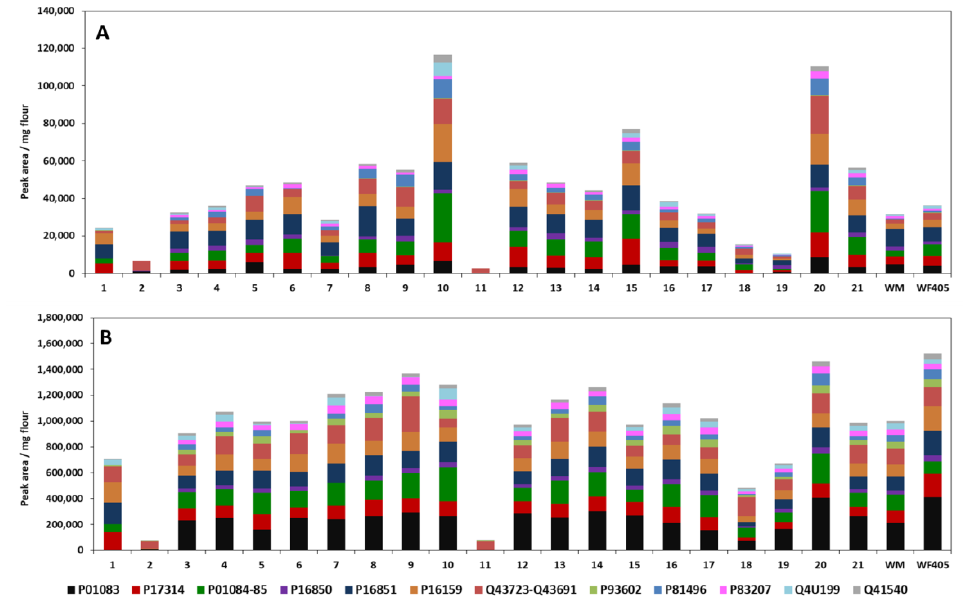
Figure 8. Distribution and relative abundance of the ATIs from Turkish wheat cultivars presented as: ( A ) peak area obtained pro mg flour applied in the investigated CM extracts of the samples and ( B ) in the option 2 Ambi / urea extracts. Peak area is the response measured by the HPLC-MS / MS analysis for the quantifier peptide for the corresponding proteins. WM and WF405 are commercially available wheat flours (WM = whole-meal flour, WF405 = extracted wheat flour type 405). See Table 2 for sample allocation.